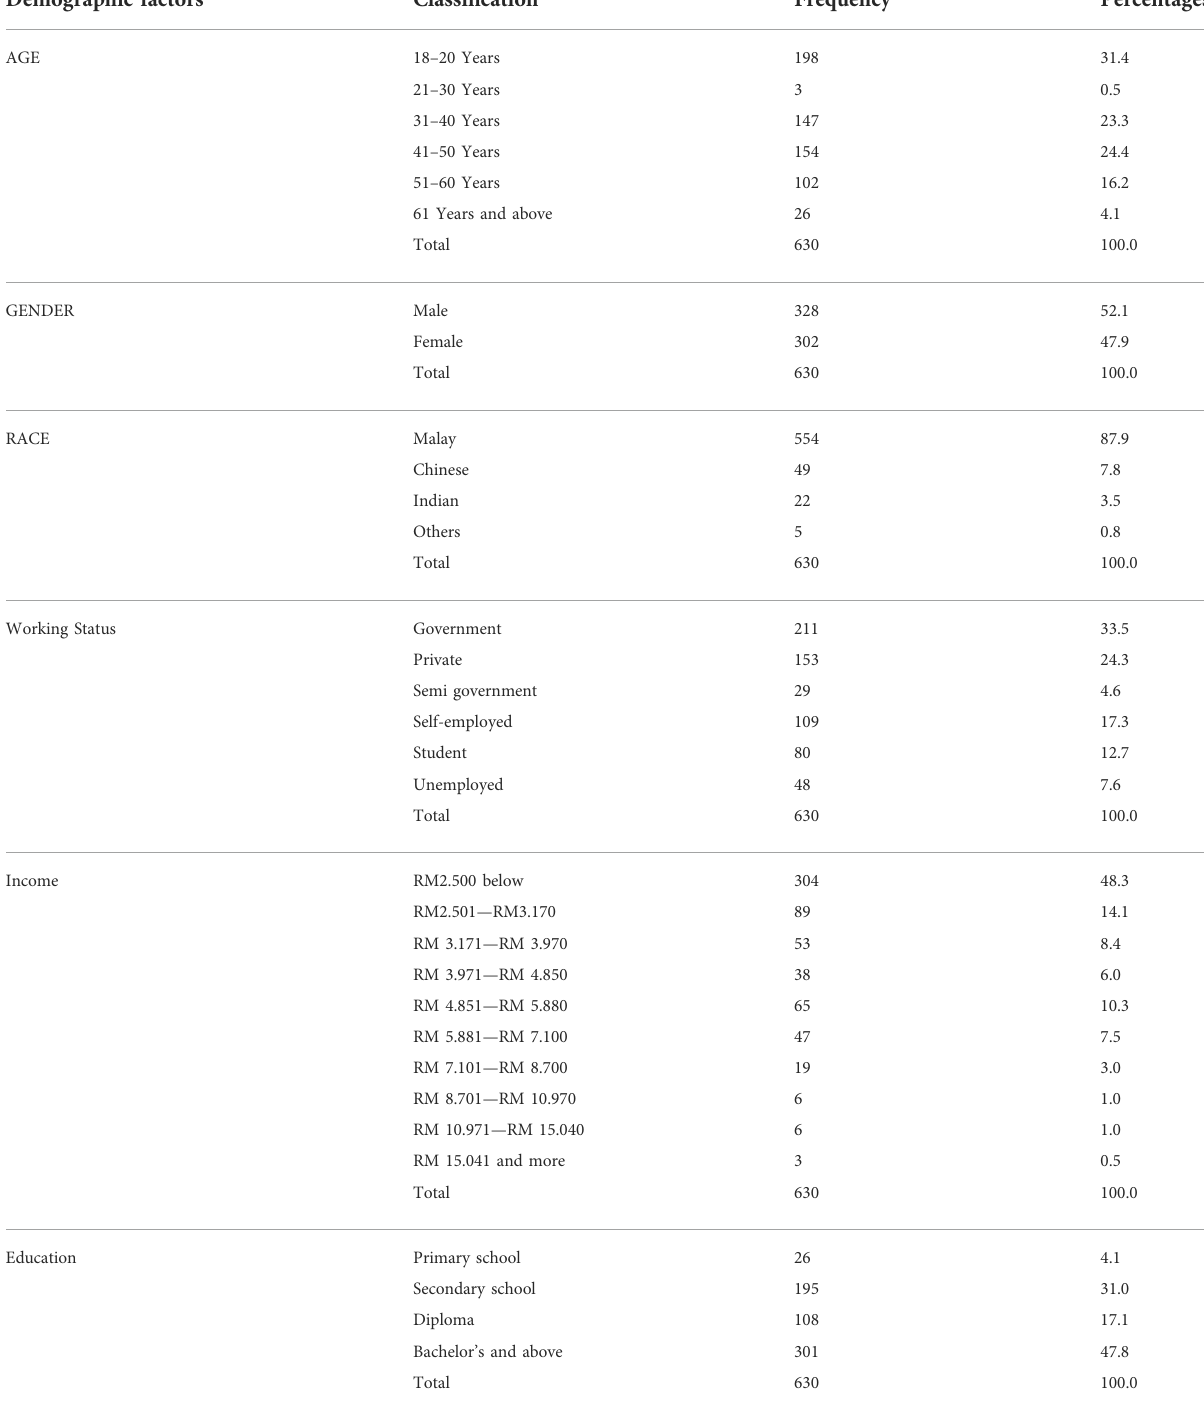
TABLE 1 Demographic characteristics of the participants ( n =